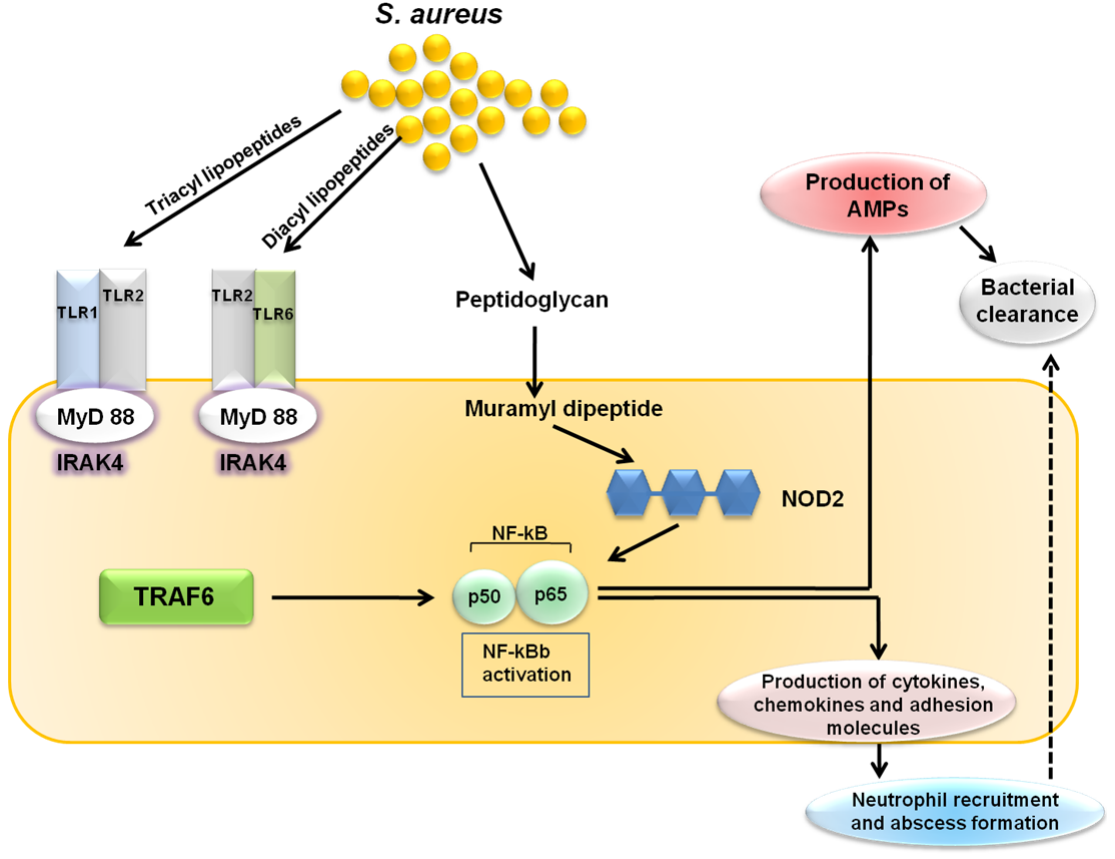
Figure 1. Toll-like receptor-mediated cutaneous immune response against S. aureus . Toll-like receptor 2 (TLR2) and nucleotide-binding oligomerization domain containing 2 (NOD2), which are expressed by keratinocytes, respectively recognize S. aureus lipopeptides/lipoteichoic acid and muramyl dipeptide. Both TLR2 and NOD2 signaling triggers the activation of nuclear factor- κ B (NF- κ B), which leads to the production of AMPs, cytokines, chemokines, adhesion molecules and granulopoesis factors, all of which contribute to the cutaneous host defense against S. aureus